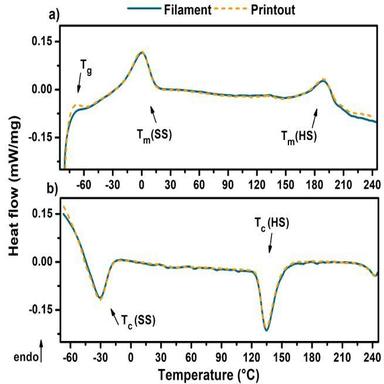
DSC thermograms of filament and Bioflex® printouts. (a) second heating run, (b) cooling run.